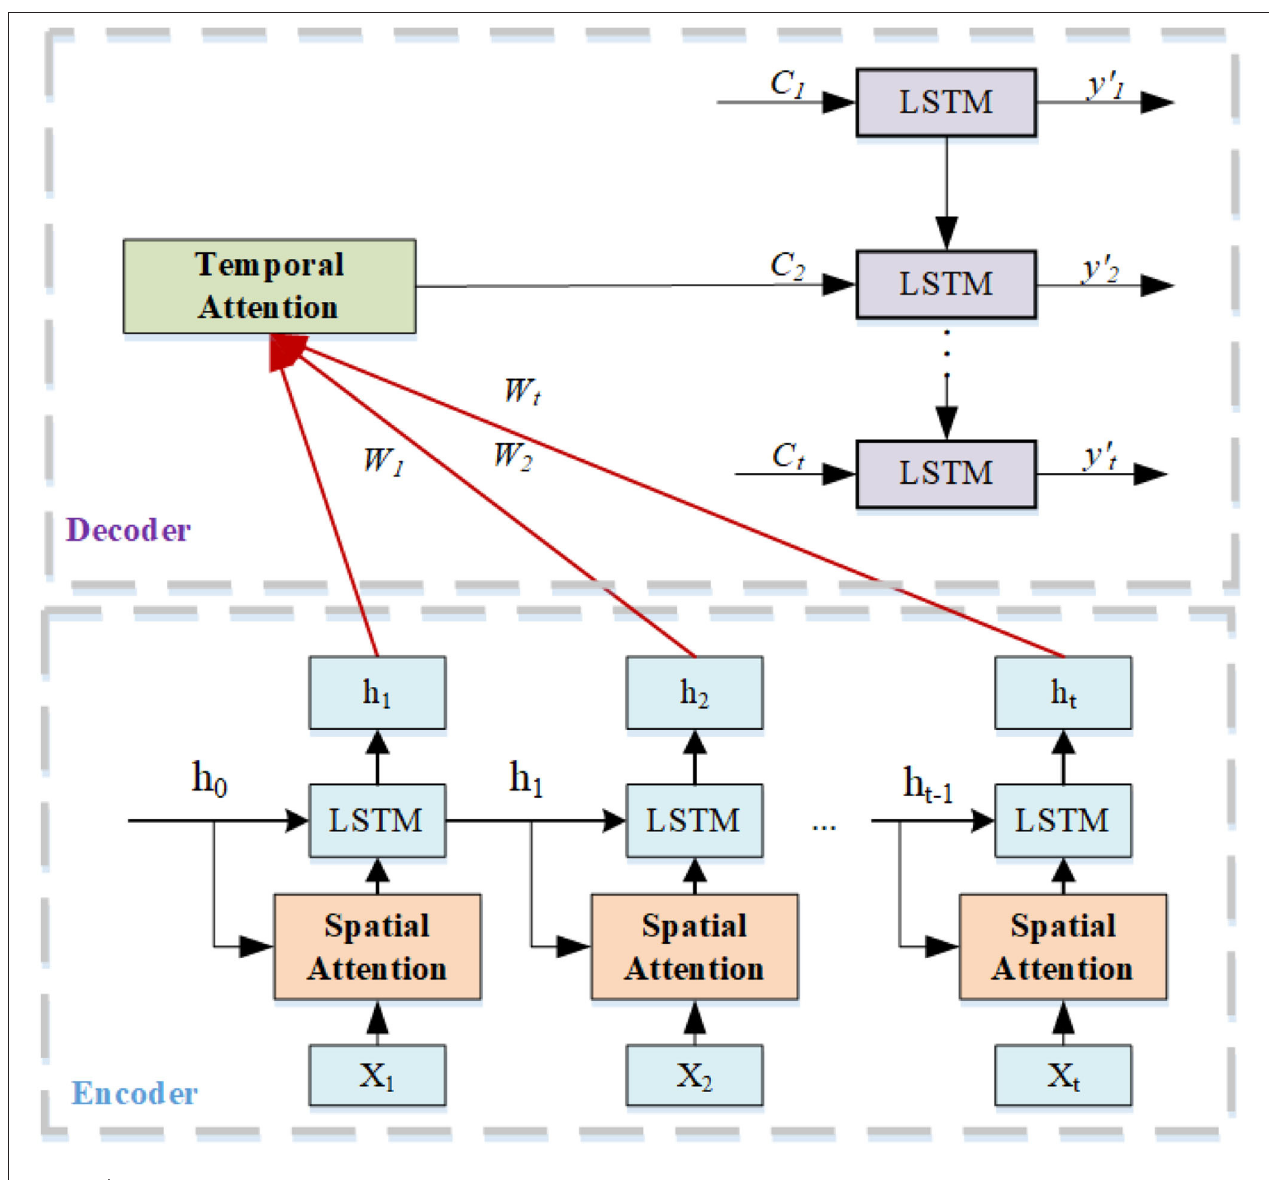
FIGURE 3 | Spatial-temporal attention